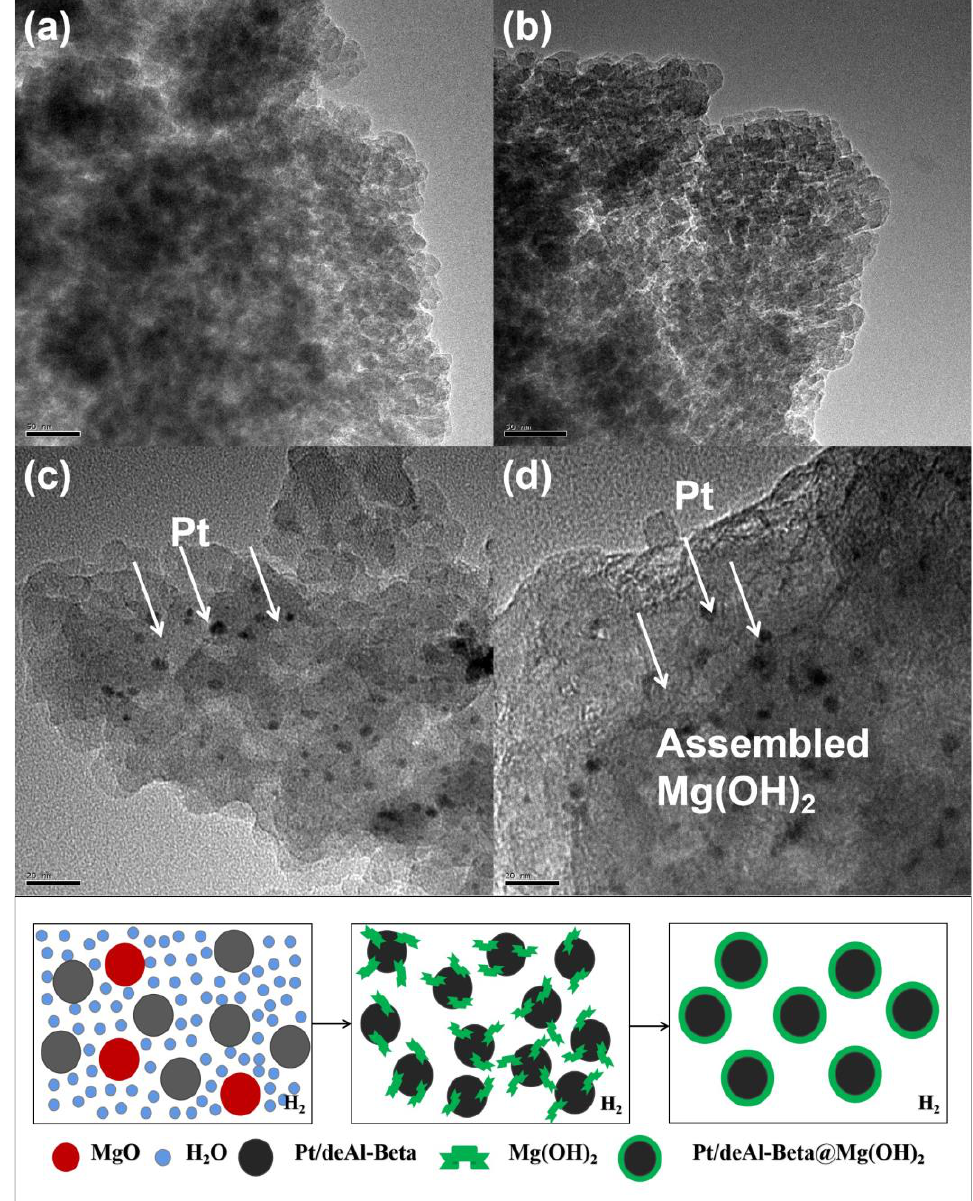
Figure 7. The TEM images of ( a ) Beta; ( b ) deAl-Beta; ( c ) Pt/deAl-Beta; ( d ) Pt/deAl-Beta@Mg(OH) 2 .